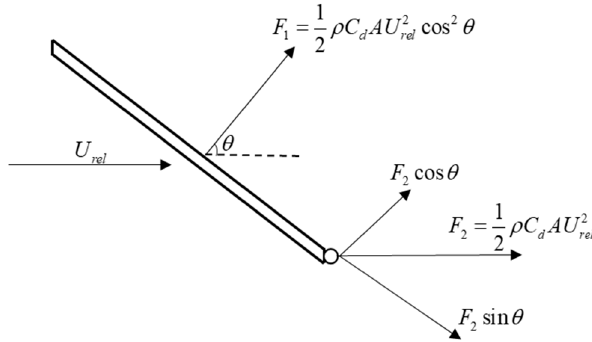
Figure 2. Force diagram for the Morrison model of orthogonal lines